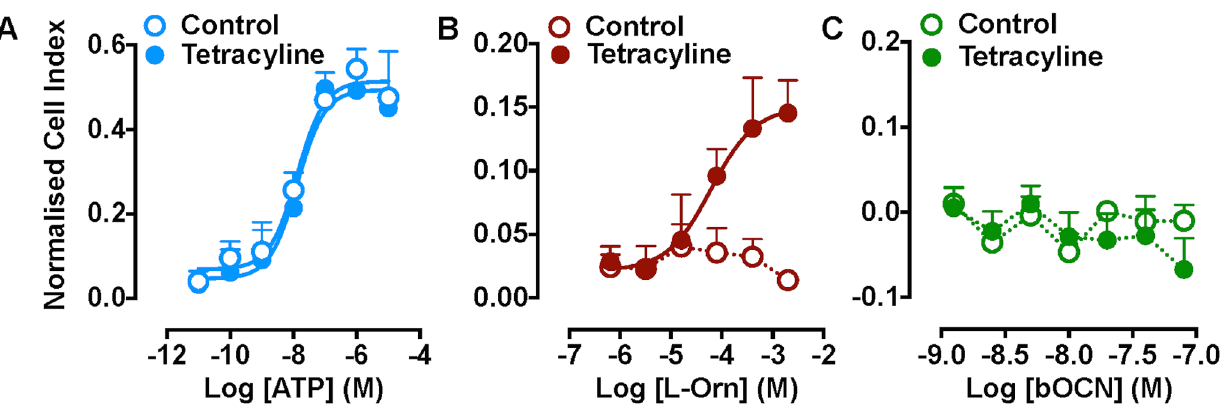
Fig 4. Measurement of cellular impedance in FlpIn-TREx-HEK293-mGPRC6A cells. (A) ATP (acting via endogenous P2Y receptors) increases cellular impedance in both tetracycline-induced and un-induced FlpIn-TREx-HEK293-mGPRC6A cells, whereas (B) L-ornithine increases cellular impedance only in tetracycline-induced cells. (C) Bovine OCN did not change cell impedance in either induced or un-induced FlpIn-TREx-HEK293-mGPRC6A cells. A similar lack of effect was shown for other OCN variants ( data not shown